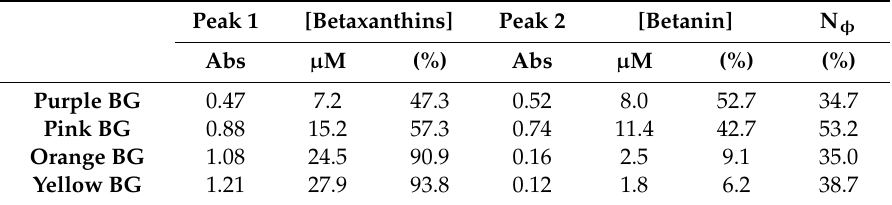
Table 3. Estimation of concentration ( µ mol) and relative percentage of betaxanthins (absorption Peak 1 at ~482 nm) and betanin (Peak 2 at ~536 nm) molecules for the four bougainvillea extracts according to Ref. [57]. The last column lists the total number of photons absorbed between 387 and 750 nm by the natural dyes in relative percentages with respect to the absorption of N719 reference